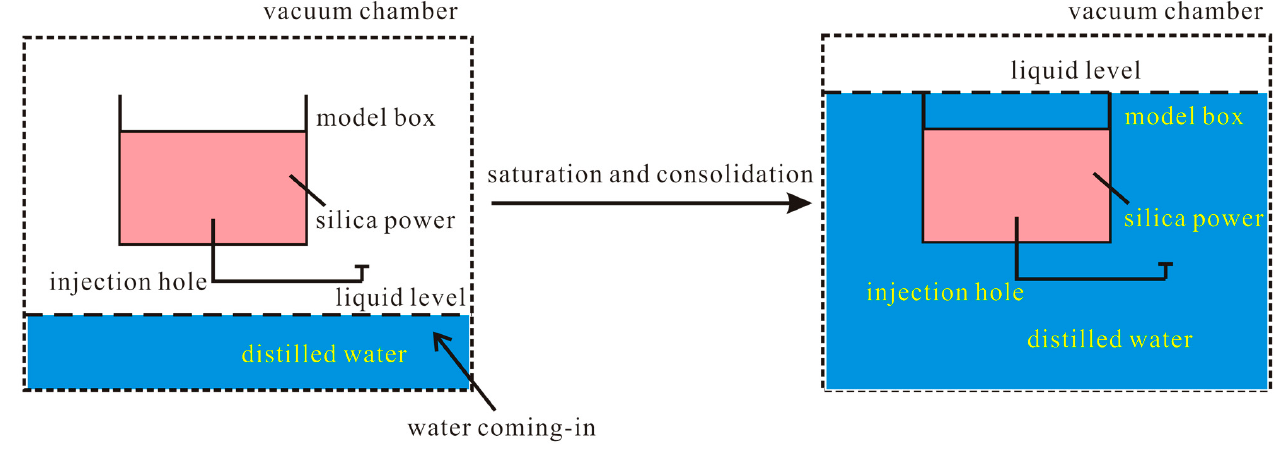
Figure 6. Schematic diagram of saturation and consolidation.